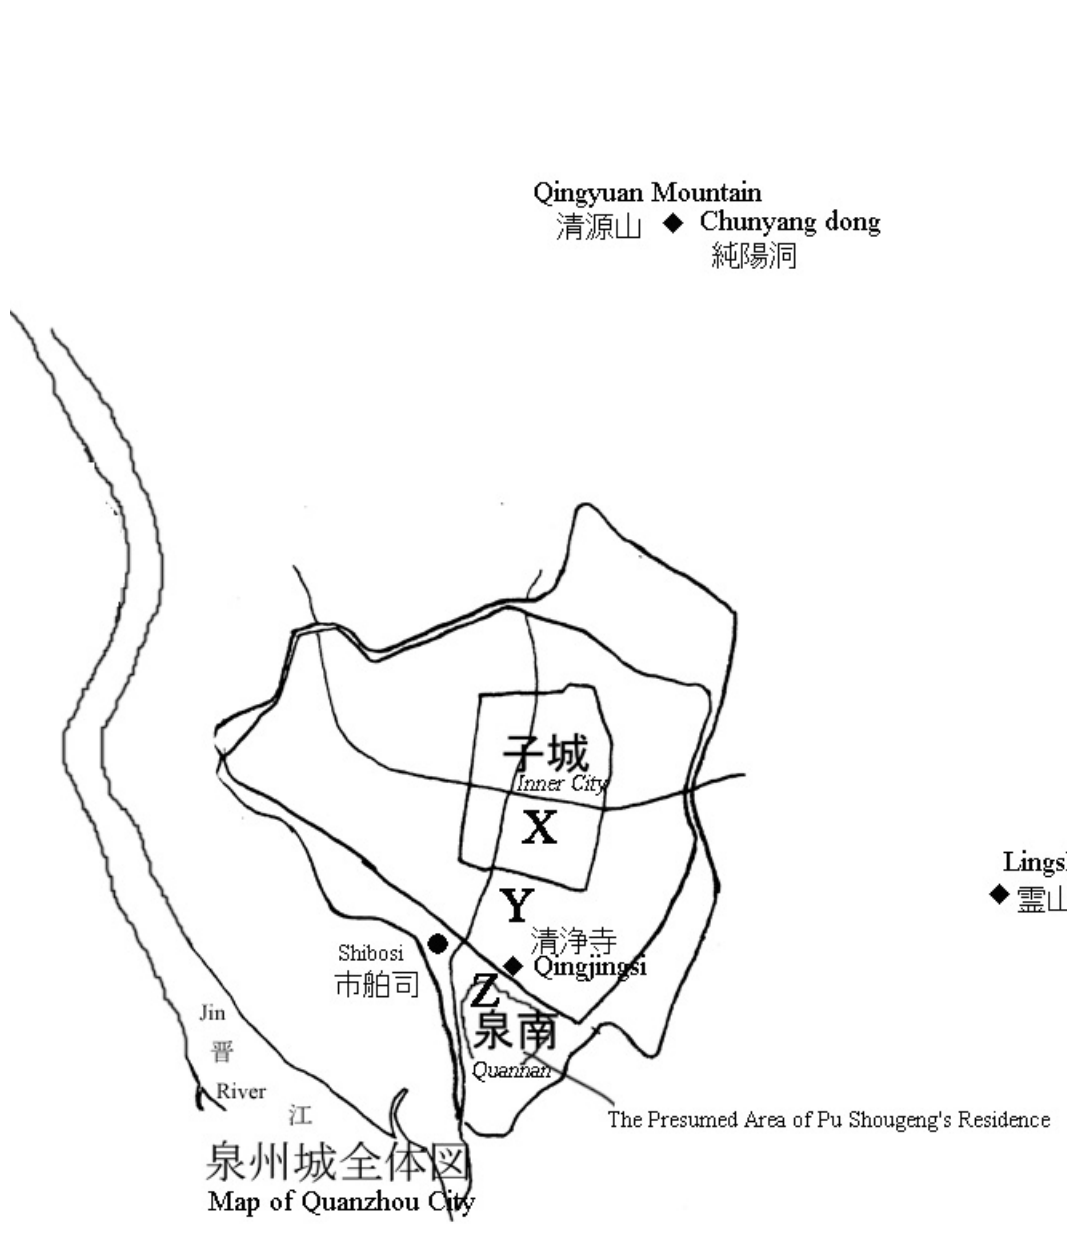
Figure 1 Map of Quanzhou city and Quannan 泉南 during the late Song period. Source: Fujian sheng Quanzhou shi diming lu (1982) and Zhunag (1988).